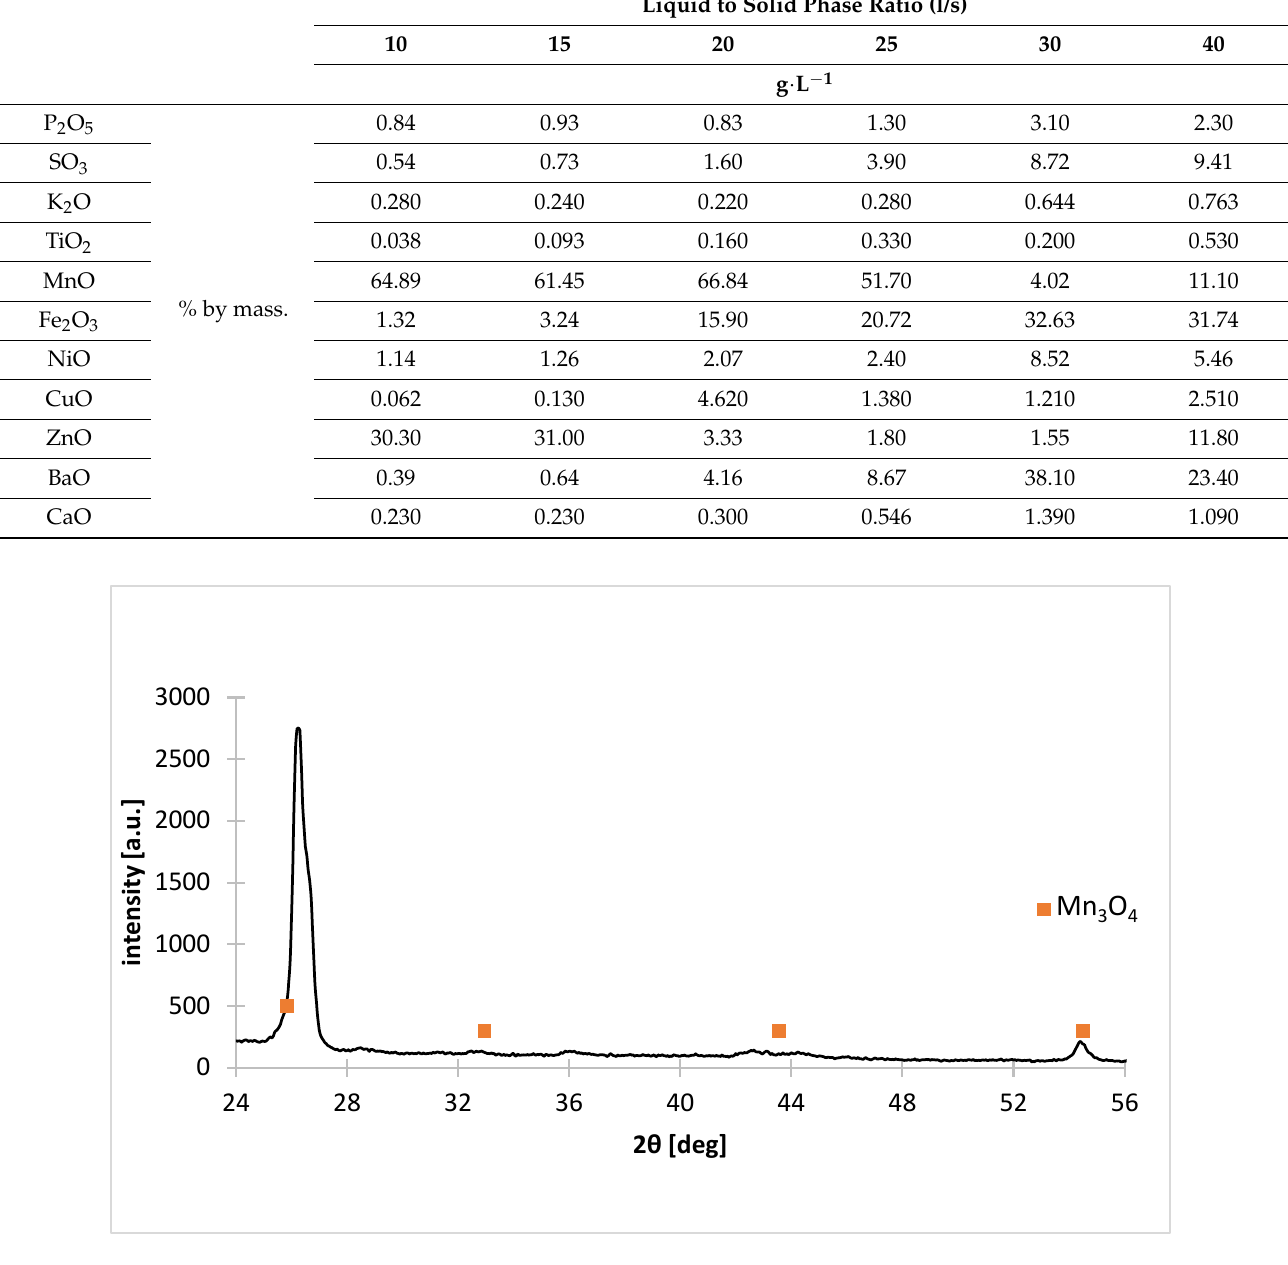
Figure 9. X-ray diffraction pattern of solid residue as a result of non-selective leaching of black mass for liquid–solid ratio = 20 g ∙ L − 1 .